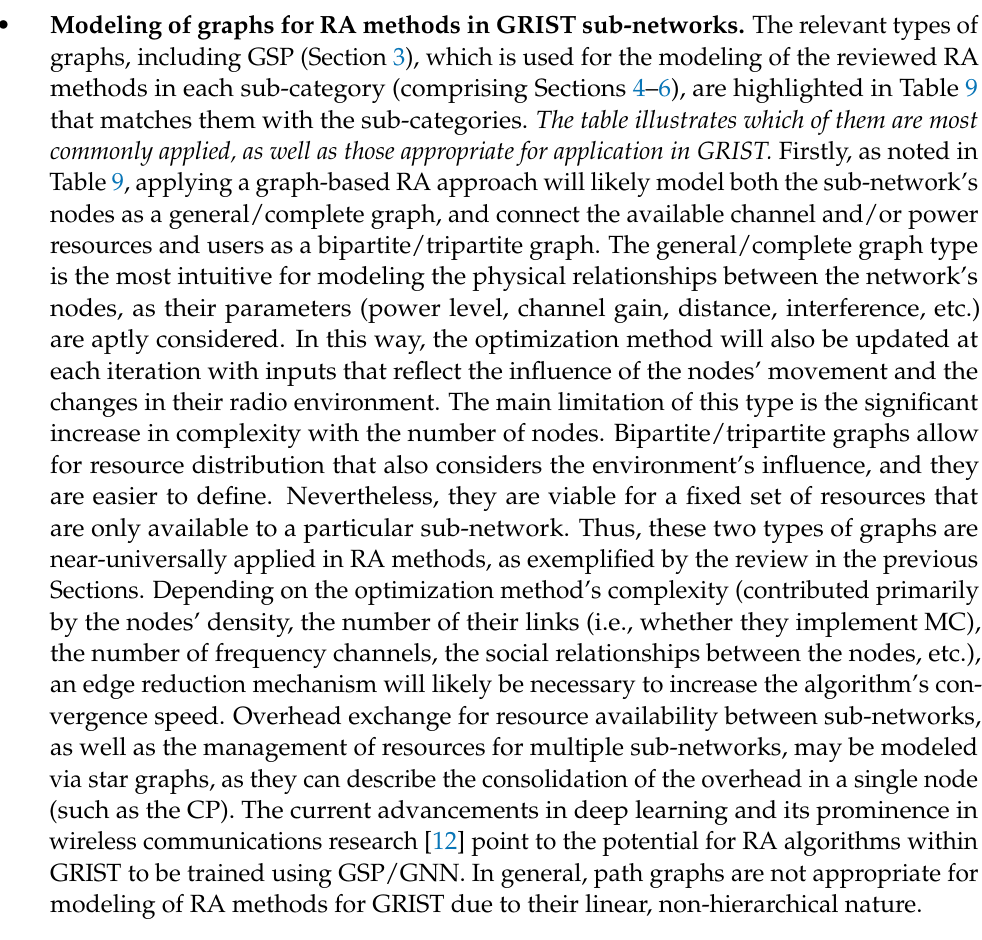
Figure 8. Illustrations for sub-networks for communication exchange over terrestrial, marine, aerial and space layers. ( a ) Sub-network comprised of terrestrial and aerial nodes. ( b ) Sub-network comprised of marine, aerial, and space